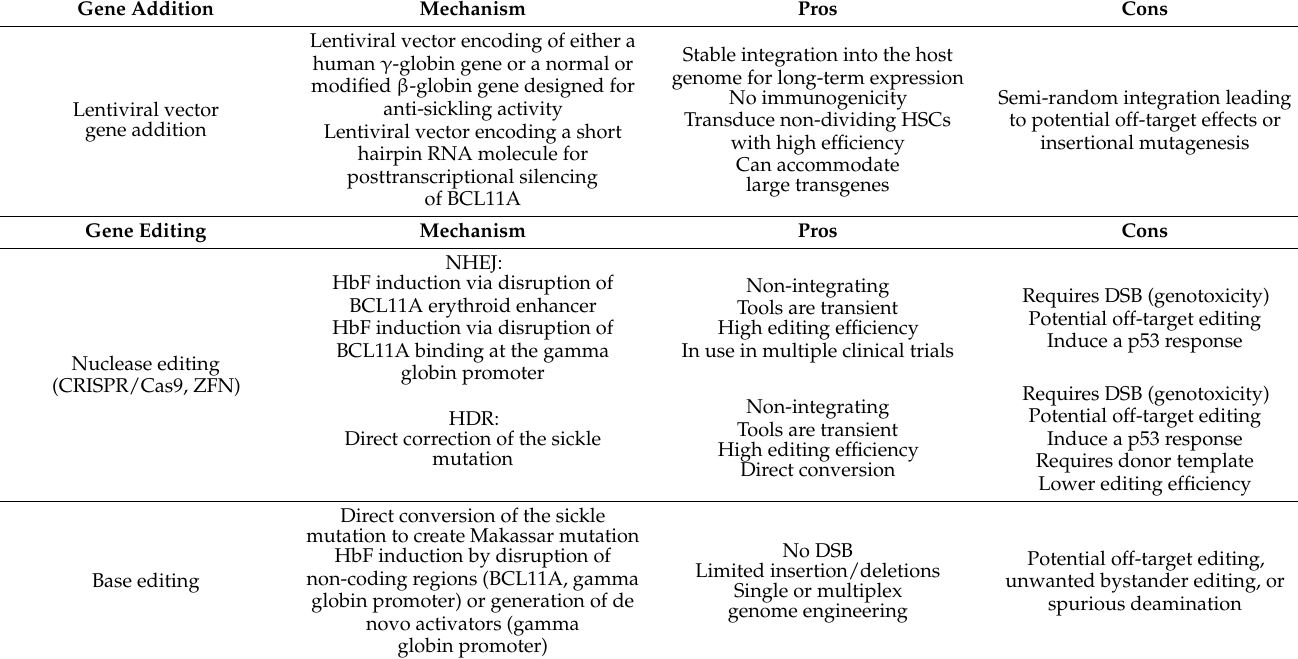
Table 4. Pros and cons of gene therapy methods for sickle cell